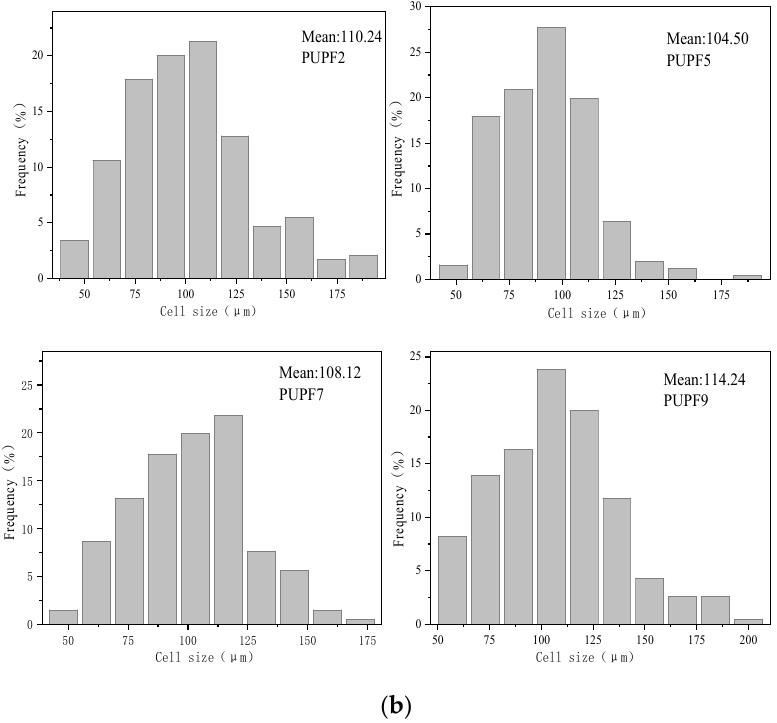
Figure 5. SEM images ( a ) of PF, PUPFs, and cell size distributions ( b ) of the PUPF2, PUPF5, PUPF7, and PUPF9.